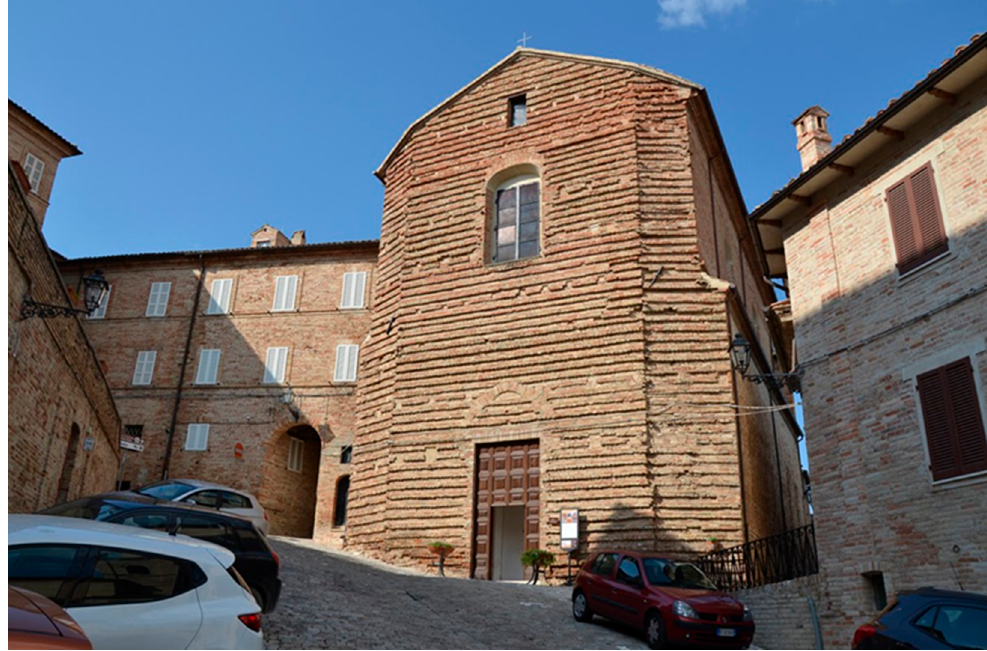
Figure 5. The unfinished façade of the Church of San Lorenzo in Montedinove (Ascoli Piceno). Order, rigor, and formal clarity are considered of primary importance for the Carducci who,